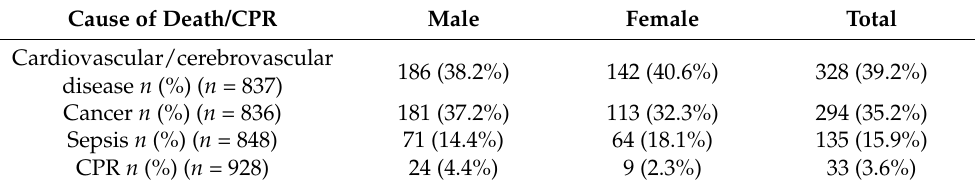
Table 3. Causes of death, comparison between donor sexes. Multiple causes of death per donor are possible.